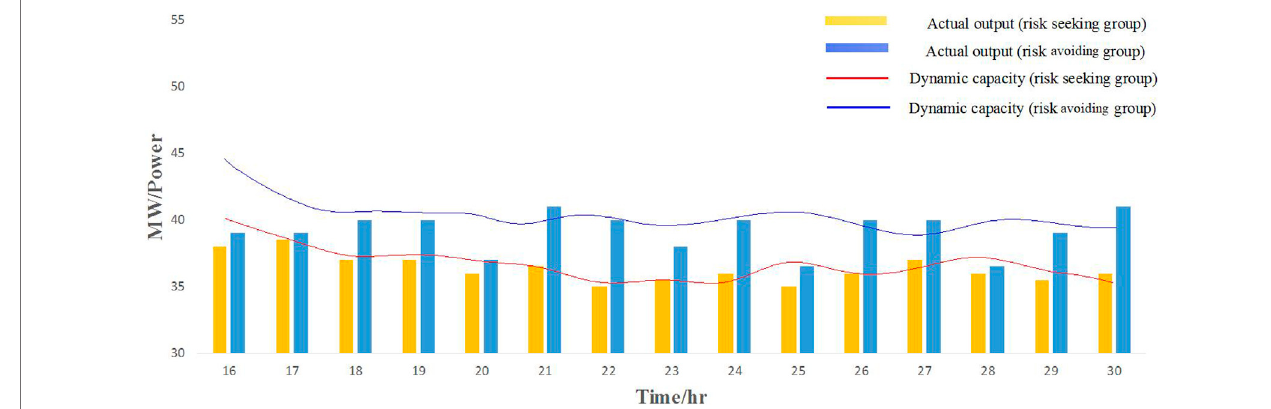
FIGURE 10 | Dynamic capacity of VPP at high risk.